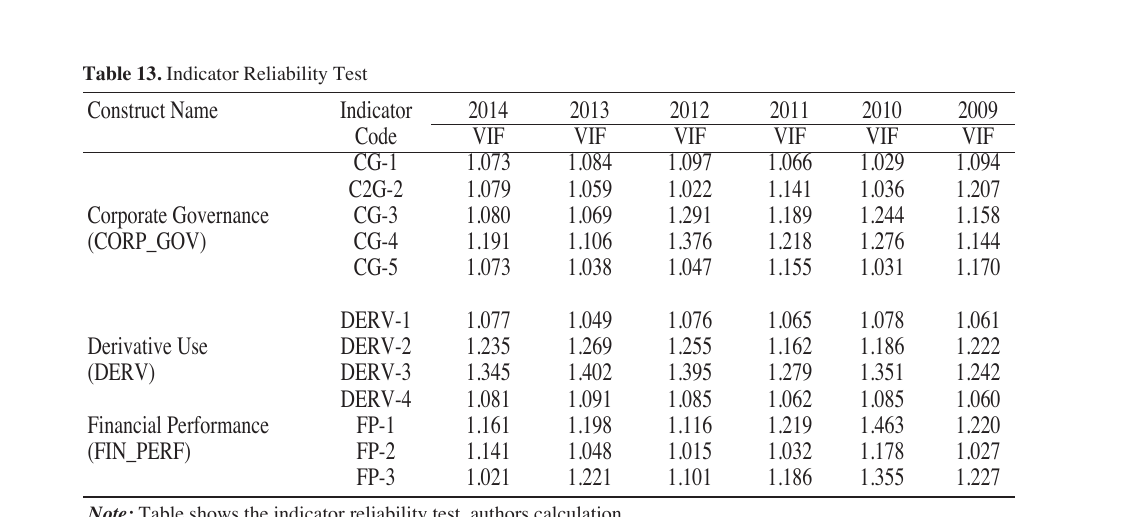
Note: Table shows the indicator reliability test, authors